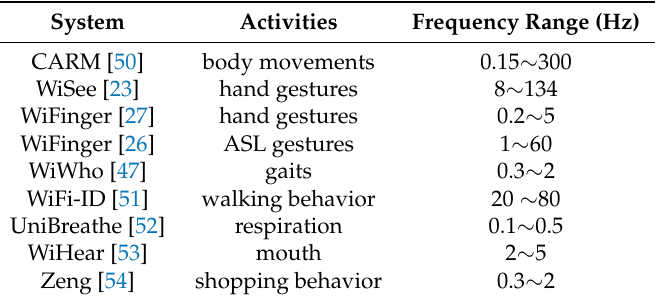
Table 1. Frequency range of common activities.